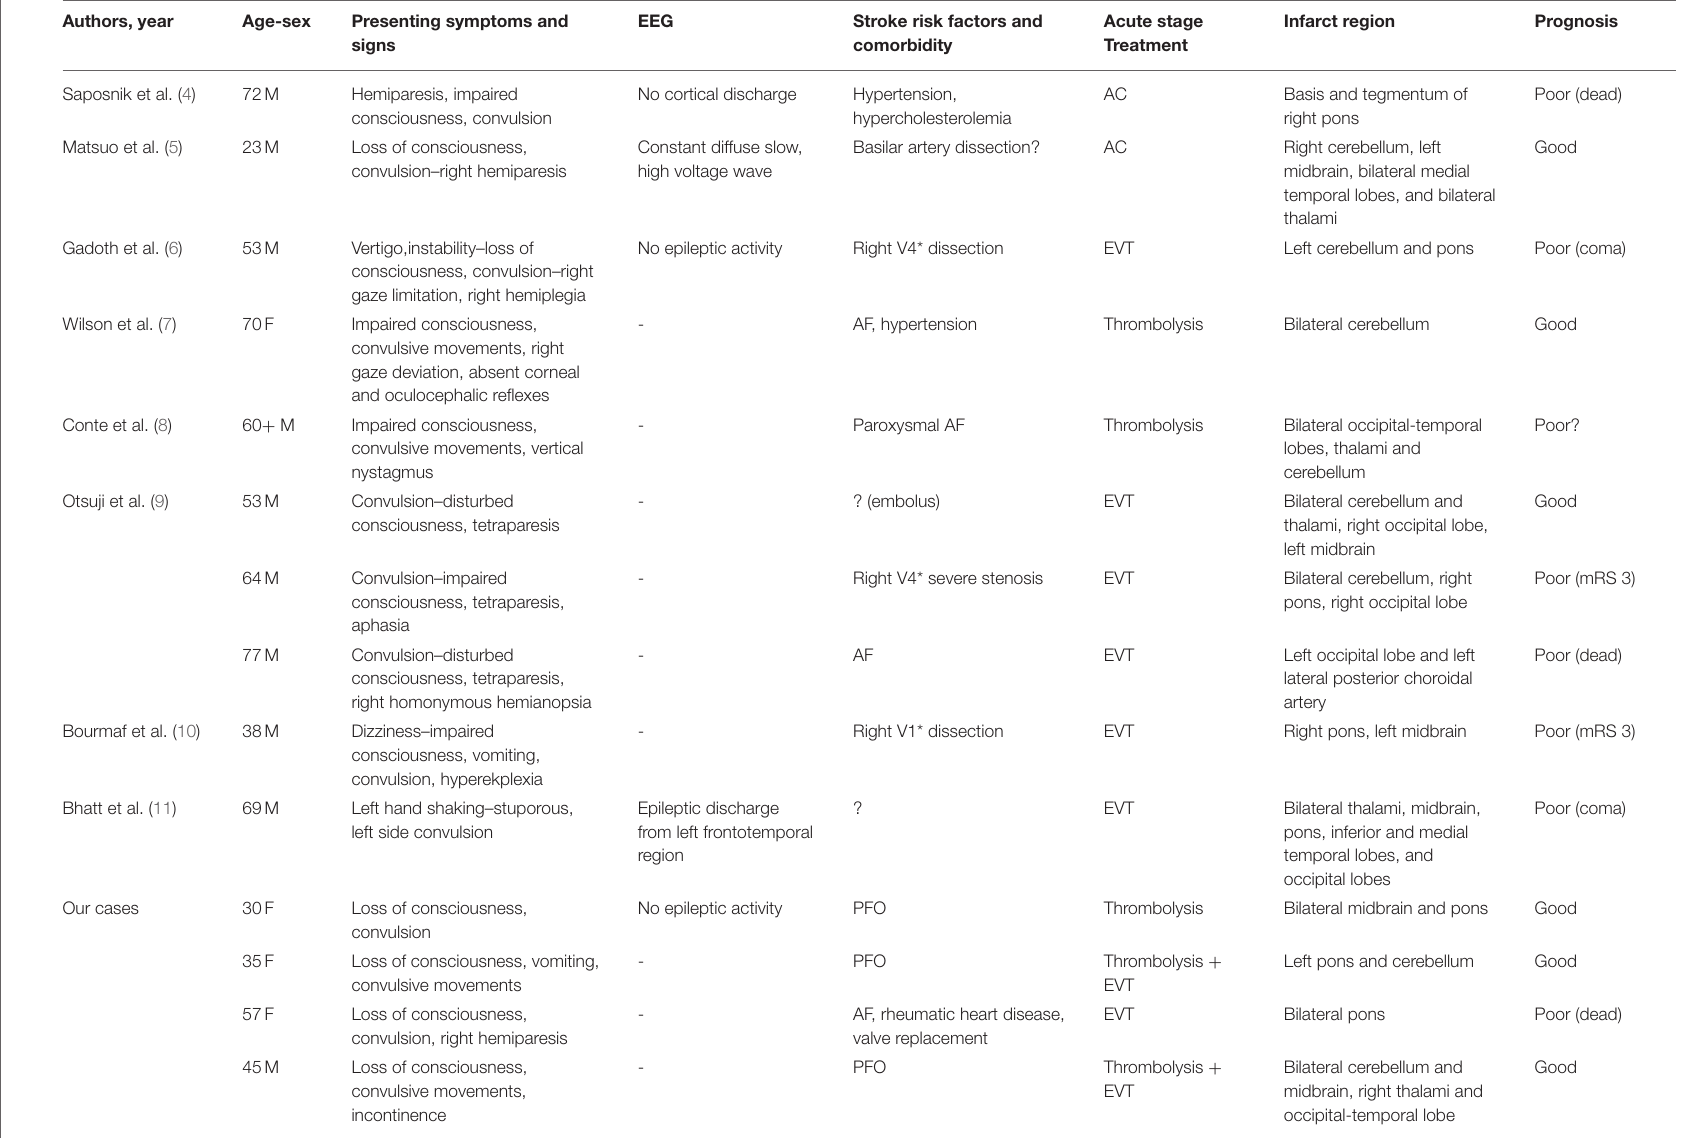
* V1 and V4 refer to the 1 st and 4 th segment of the vertebral artery, respectively. AC, anti-coagulation; AF, atrial fibrillation; EEG, electroencephalogram; EVT, endovascular thrombectomy; mRS, modified Rankin Scale; PFO, patent foramen